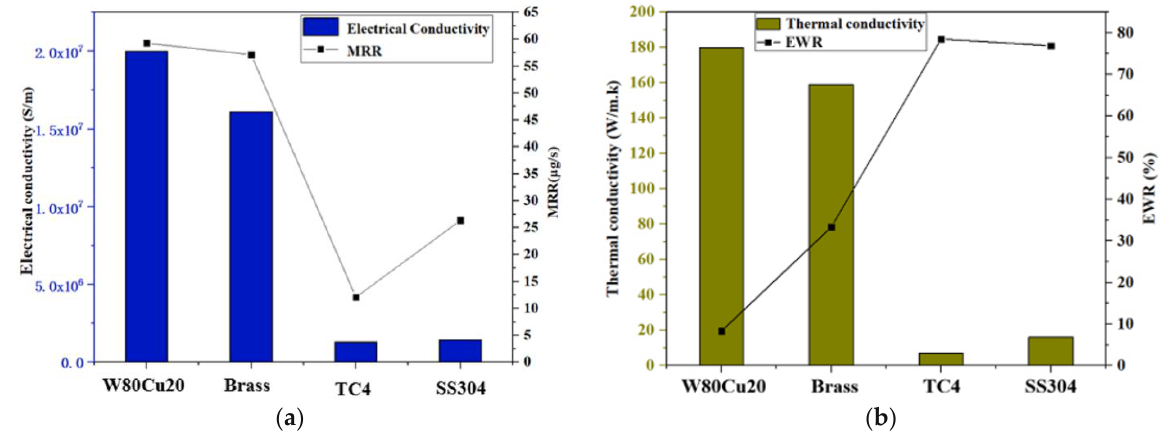
Figure 5. Influence of electrical conductivity and thermal conductivity of different electrodes under machining conditions Ton = 12 μs, Toff = 12 μs, Ip = 14.17 A; ( a ) MRR and ( b ) EWR.